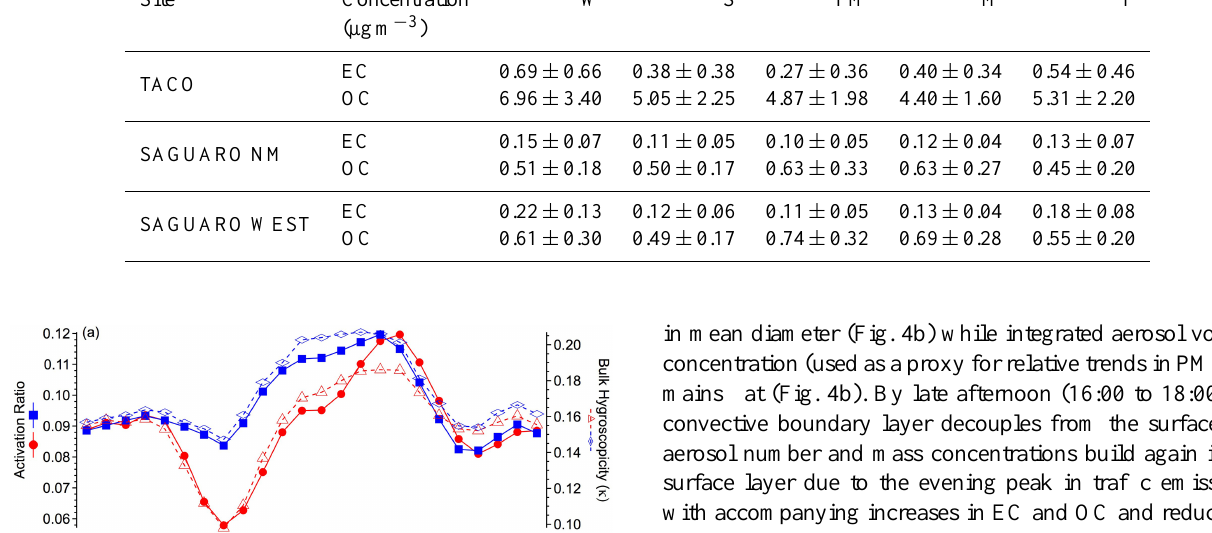
Table 2. Seasonal mean OC and EC concentrations, and associated standard deviations, at the TACO and IMPROVE sites. Site Concentration